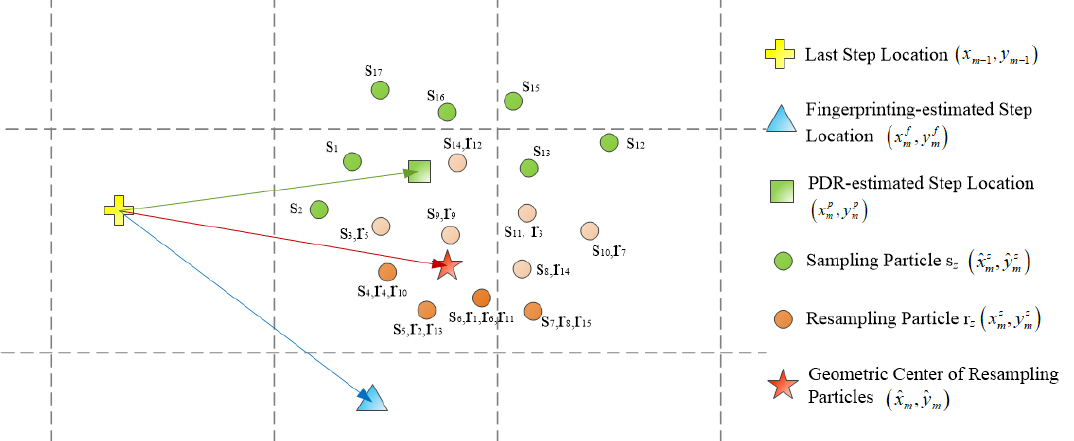
Figure 4. The process of particle filtering. First, some particles (the dots) are formed around the PDR-based estimated position (the square) according to Equation (5). Second, the particles are resampled according to the weights computed by Equation (6) after calculating the position (the triangle) of the RSS fingerprint estimation. s z represents the z th sampled particle and r z denotes the particle obtained after the resampling of the z th particle. Finally, the geometric center of the particle (the star) can be